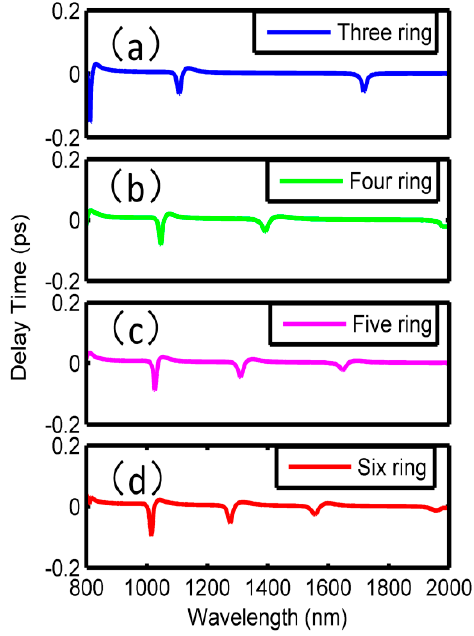
Figure 7. Group delays of multiring resonators.